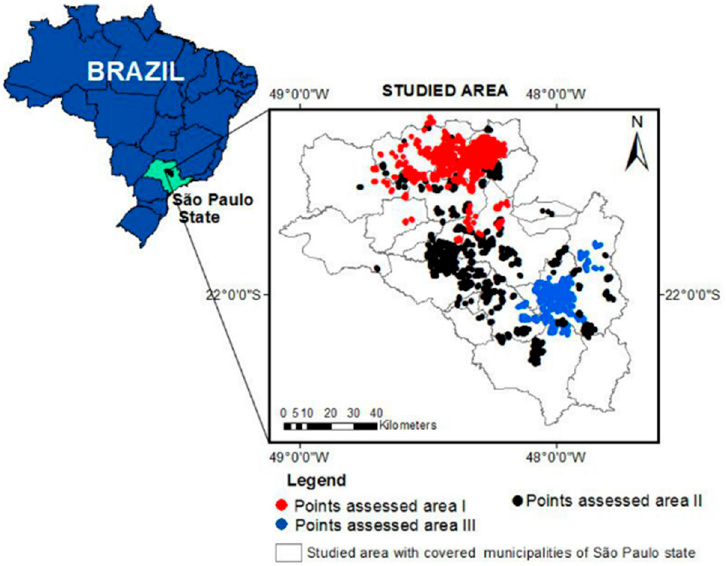
Figure 1. Location of the study site and sampling points in Areas I, II, and III.